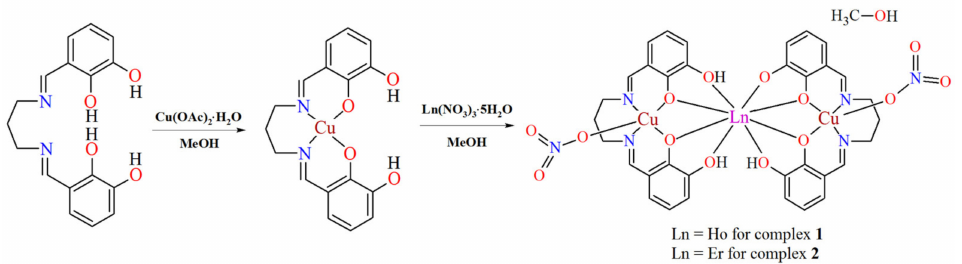
Figure 3. The scheme of the synthetic route of complexes 1 and 2